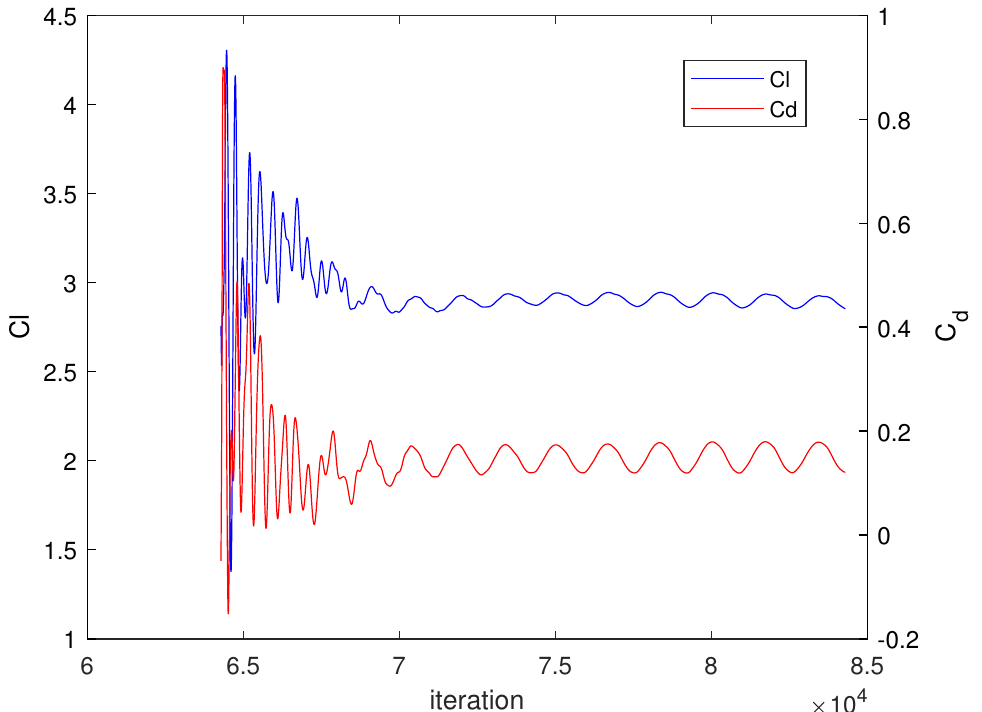
Figure 13. Evolution of C l and C d coefficients during the NLR7301 SDO for M ∞ = 0.185 and α = 10.1 ◦ .